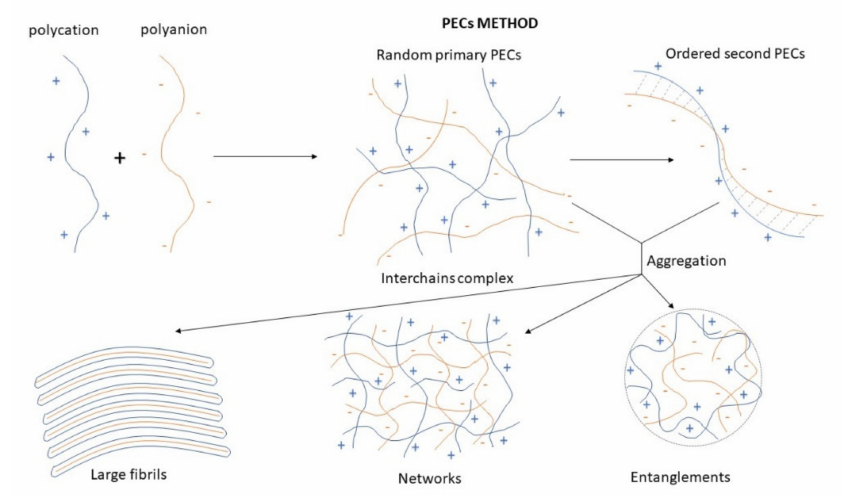
Figure 4. Scheme of the different steps of the polyelectrolyte complexes